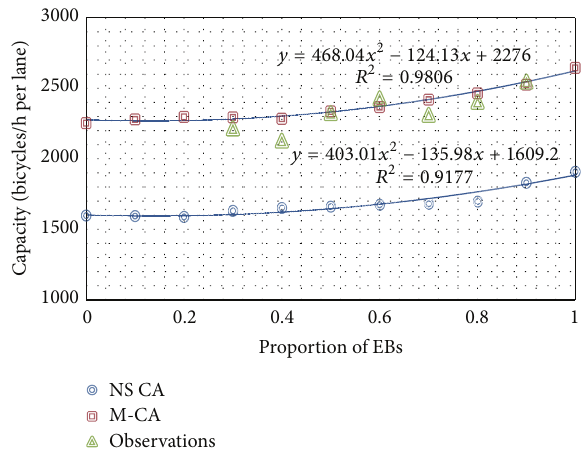
Figure 9: Observed and simulated capacities under different pro- portions of